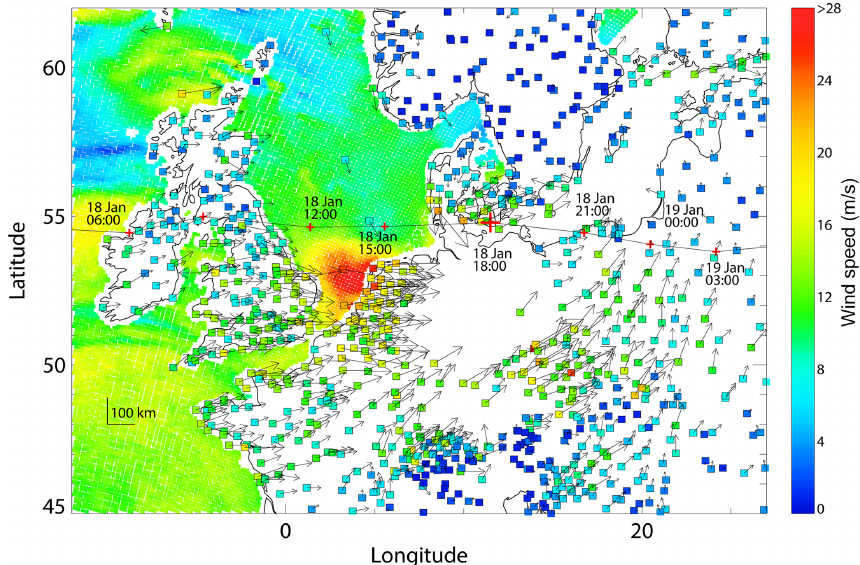
Figure 1. Wind speed and direction for Storm Kyrill at 18:00UTC 18 January 2007 from selected stations of the USAF data set. The trajectory of the low pressure centre is indicated by the black line with red crosses at 3h intervals (Roberts et al., 2014; XWS, 2023). The location of the pressure centre at the time of wind field is shown by a larger cross. QuikSCAT sea surface wind speeds are shown for a satellite overpass at about 19:10UTC or ∼ 70min after the synoptic station